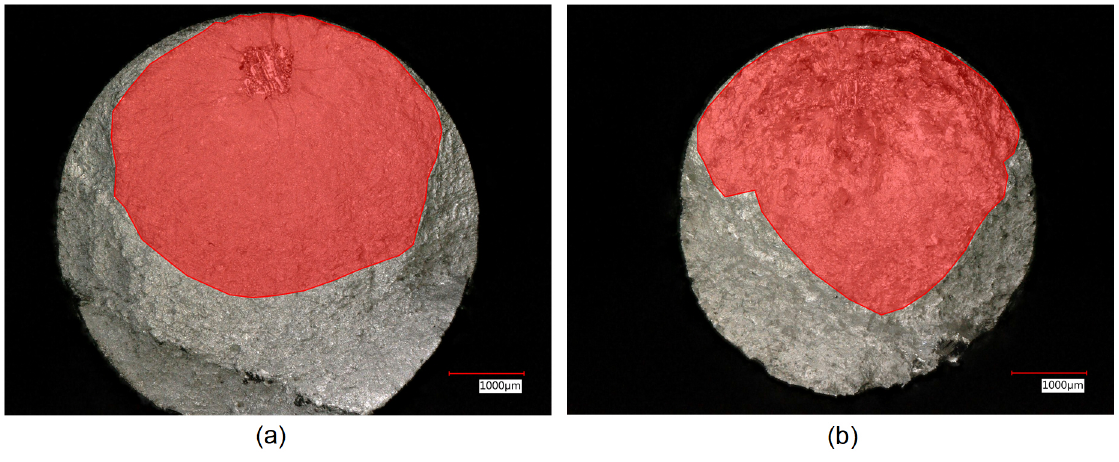
Figure 15. Final failure area before ductile fracture for ( a ) Ti6Al4V and ( b ) Inconel